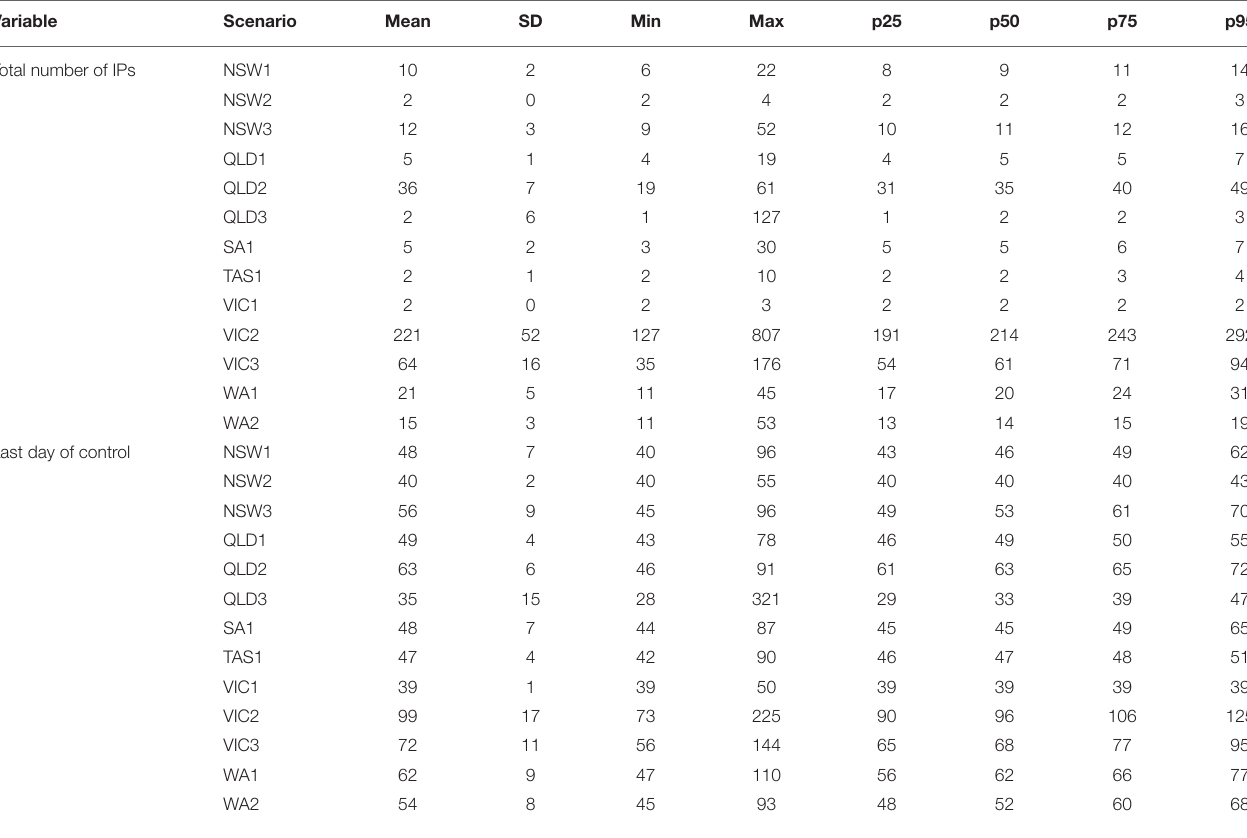
TABLE 5 | Descriptive statistics for Control Strategy 3 for all incursion scenarios.